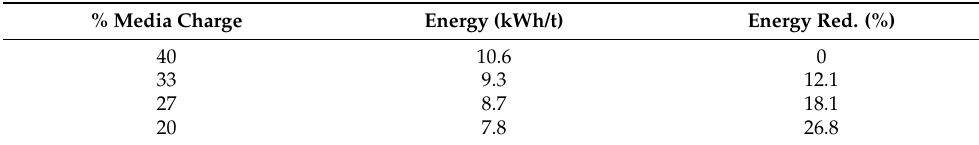
Figure 9. ( A ) Evaluation of the energy consumption reduction ratio when an operating condition is varied, ( B ) evaluation of the reduction ratio of the parameter F 300 when an operating condition is varied, ( C ) best energy performance of each item studied, compared with the control parameters using rod milling. The selected experiments are Vc (50%), media charge (20%), S/L (60%), feed flow rate (3000 g/min), rod size (30 mm), and lifter height (35 mm). Table 8. Energy reduction ratio when the media charge is reduced and the starting point is 40% media